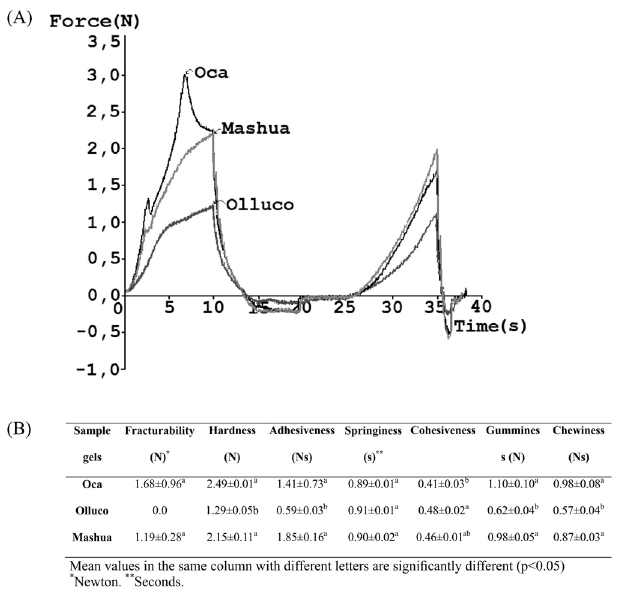
FIGURE 7 - (A) Texture profile analysis (TPA) curves of oca, olluco and mashua starch gels (6% w/w). (B) Measured TPA